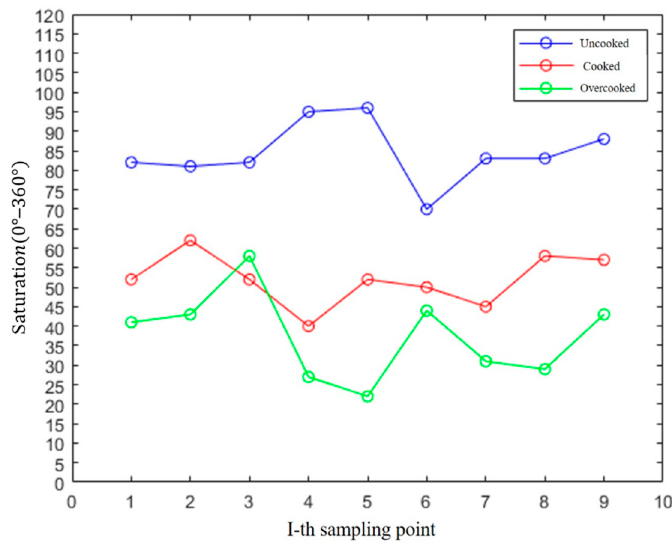
Figure 11. Saturation changes in nine marker points.